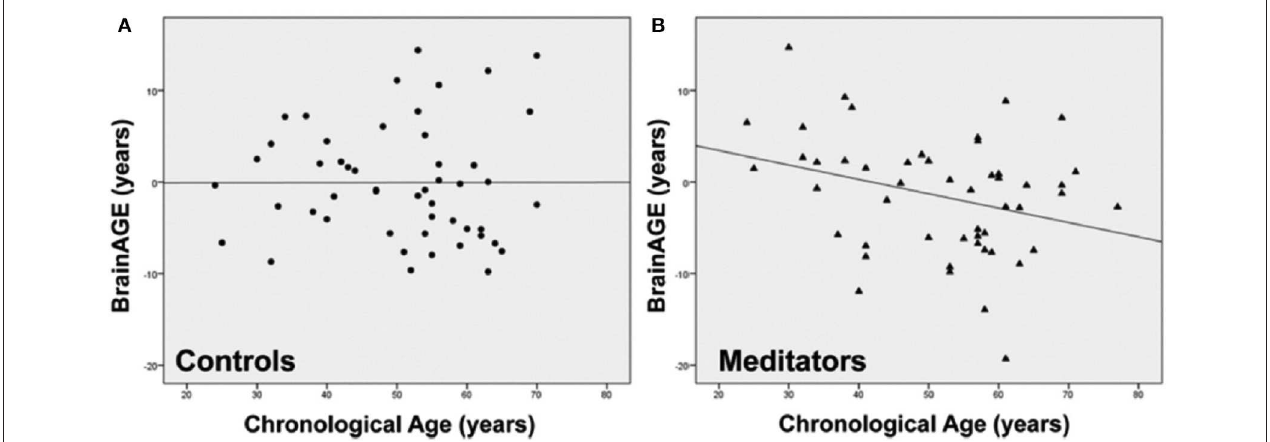
FIGURE 10 | Group-specific links between age-related measures. Scatterplots and regression lines were generated separately for (A) controls (circles) and (B) meditation practitioners (triangles). The x-axes display the chronological age; the y-axes display the BrainAGE index (negative values indicate that participants’ brains were estimated as younger than their chronological age, positive values indicate that participants’ brains were estimated as older). [Figures and legend reproduced from Luders et al. (43), with permission from Elsevier].